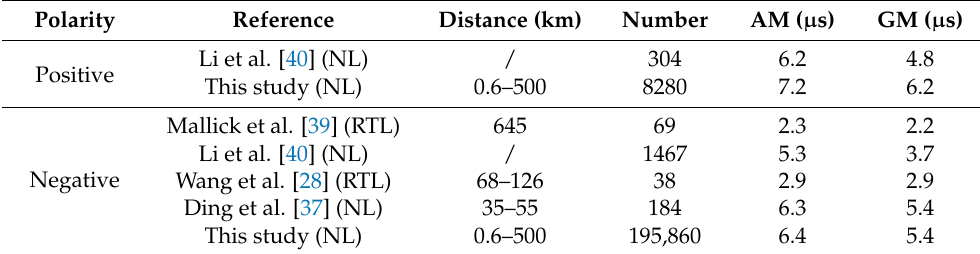
Figure 6. Histograms of half-peak width for RS pulses: ( a ) positive RS; ( b ) negative RS; Here, Min, Max, AM, GM, and SD are abbreviations for Minimum, Maximum, Arithmetic mean, Geometric mean, and Standard deviation, respectively. Table 2. Comparison of half-peak width among different studies.